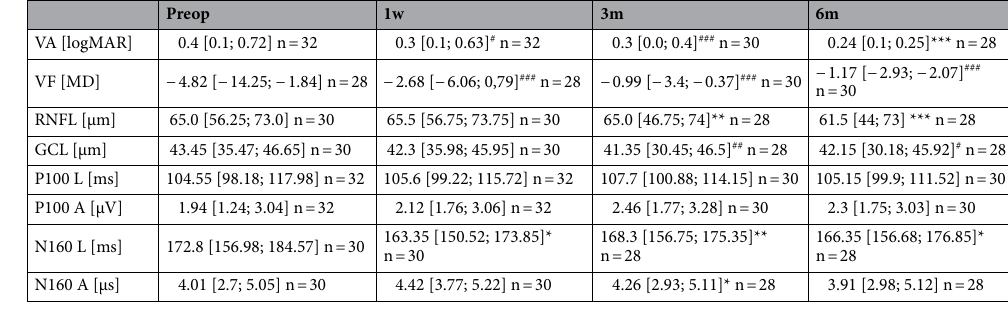
Table 1. Summary of the medians and interquartile ranges of measured parameters (VA, VF, OCT, VEPs) preoperatively and postoperatively. VA visual acuity, VF visual field, GCL ganglion cell layer, RNFL retinal nerve fiber layer, L latency (peak time), A amplitude, Preop preoperatively, w week (postoperatively), m month (postoperatively), # p < 0.05, ## p < 0.01, ### p < 0.001 (Wilcoxon signed-rank test), *p < 0.05, **p < 0.01, ***p < 0.001 (paired t test). For more detailed statistical analysis see Supplementary